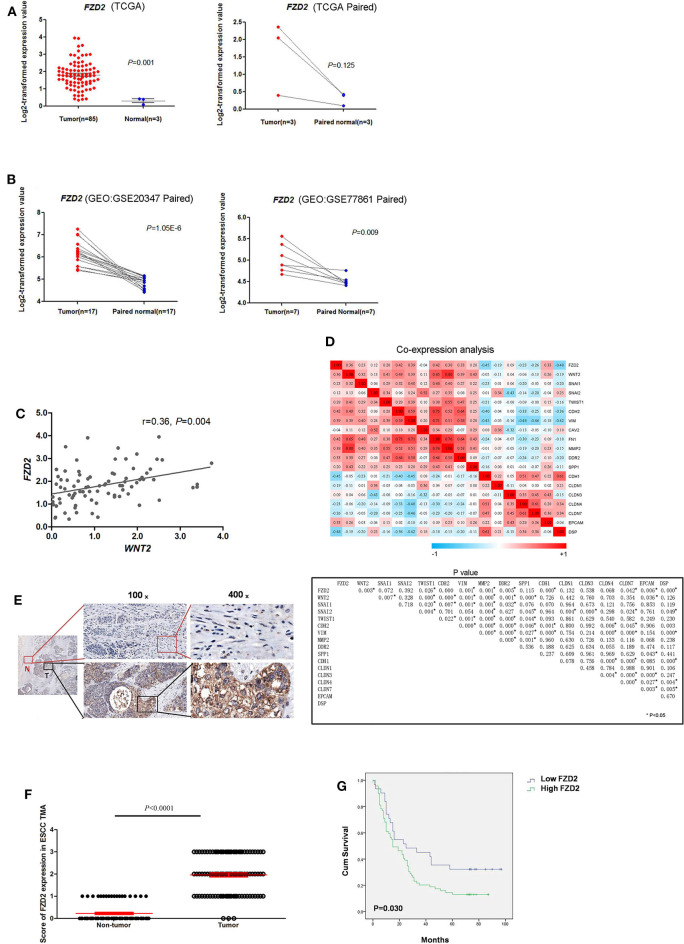
FZD2 was significantly up-regulated in patients with ESCC. The expression levels of FZD2 in non-matched and matched ESCC and normal tissue datasets from the TCGA (A) and GEO (B) databases were analyzed. (C) The correlation between WNT2 and FZD2 in ESCC and normal tissue datasets from the TCGA database. (D) Heatmaps showed the correlations between FZD2 and WNT2 expression with the mRNA expression of mesenchymal and epithelial markers in ESCC tissues in datasets from the TCGA. P-values were adjusted using the FDR method and are shown below. (E) IHC staining showed higher FZD2 expression in ESCC tissues (T) and lower or negative expression in adjacent non-tumor tissues (N). (F) Scores corresponding to the FZD2 expression levels in non-tumor and ESCC tissues from all 180 informative cases from the TMA. (G) Kaplan-Meier survival analysis stratified according to the FZD2 expression in 100 informative ESCC samples (P = 0.030 using the log-rank test) (*P < 0.05).